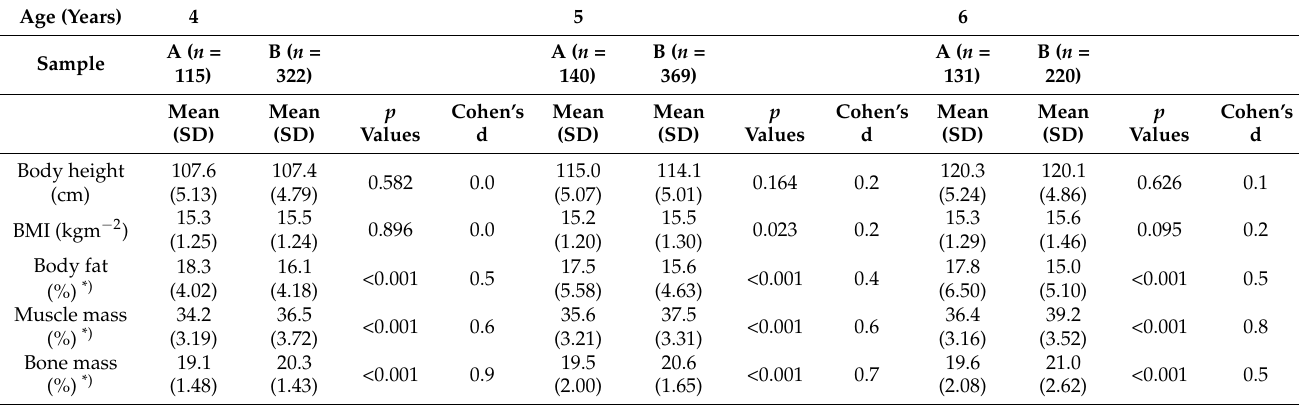
Table 1. Comparison of monitored somatic traits in present Czech preschool children aged 4–6 years with sample 1990—boys.